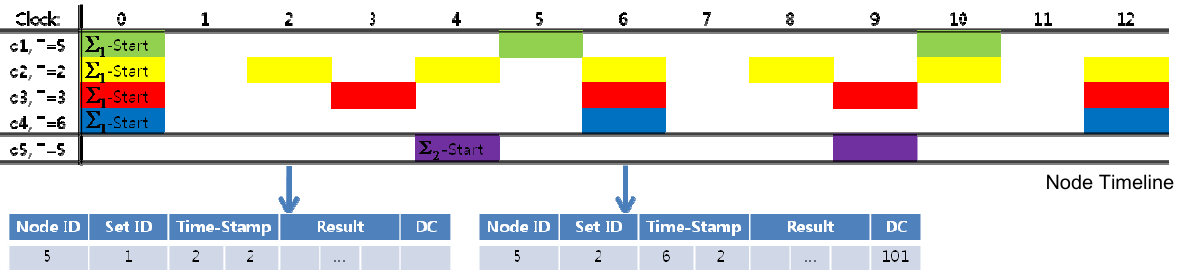
Figure 8. Examples of response messages at two different points in time. The first response message has no disambiguation code because there is no possible